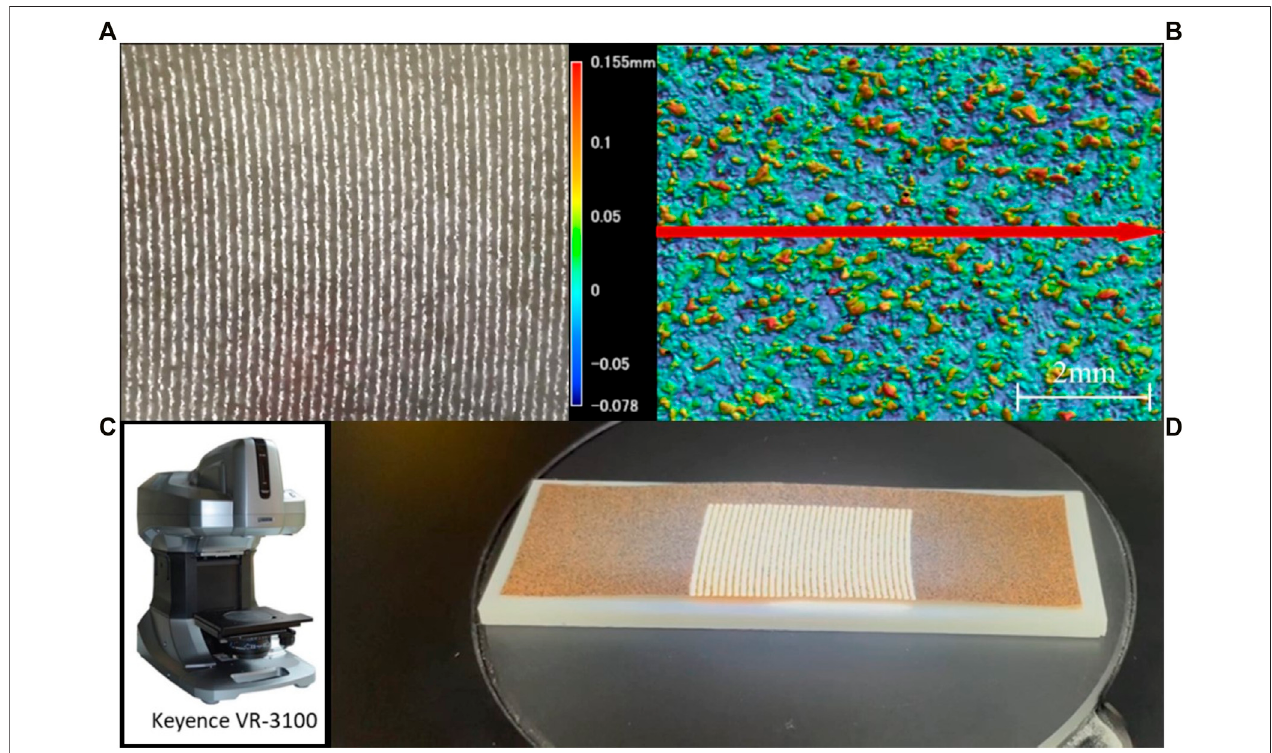
FIGURE 1 | 3D measurement of sandpaper. (A) The deformation of the stripe pattern. (B) Height image measured by (C) 3D microscope. The red arrow indicates where the line roughness is acquired. (D) Microscope projects the light of the stripe pattern onto the